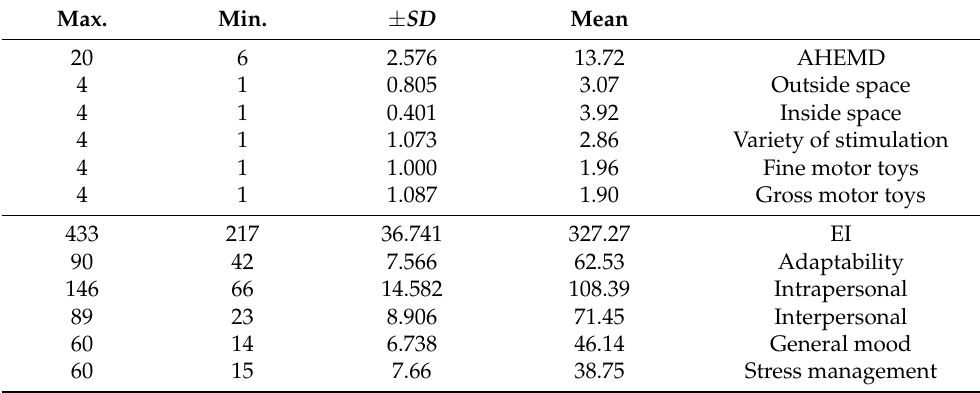
Table 1. Descriptive data of AHEMD and EI.